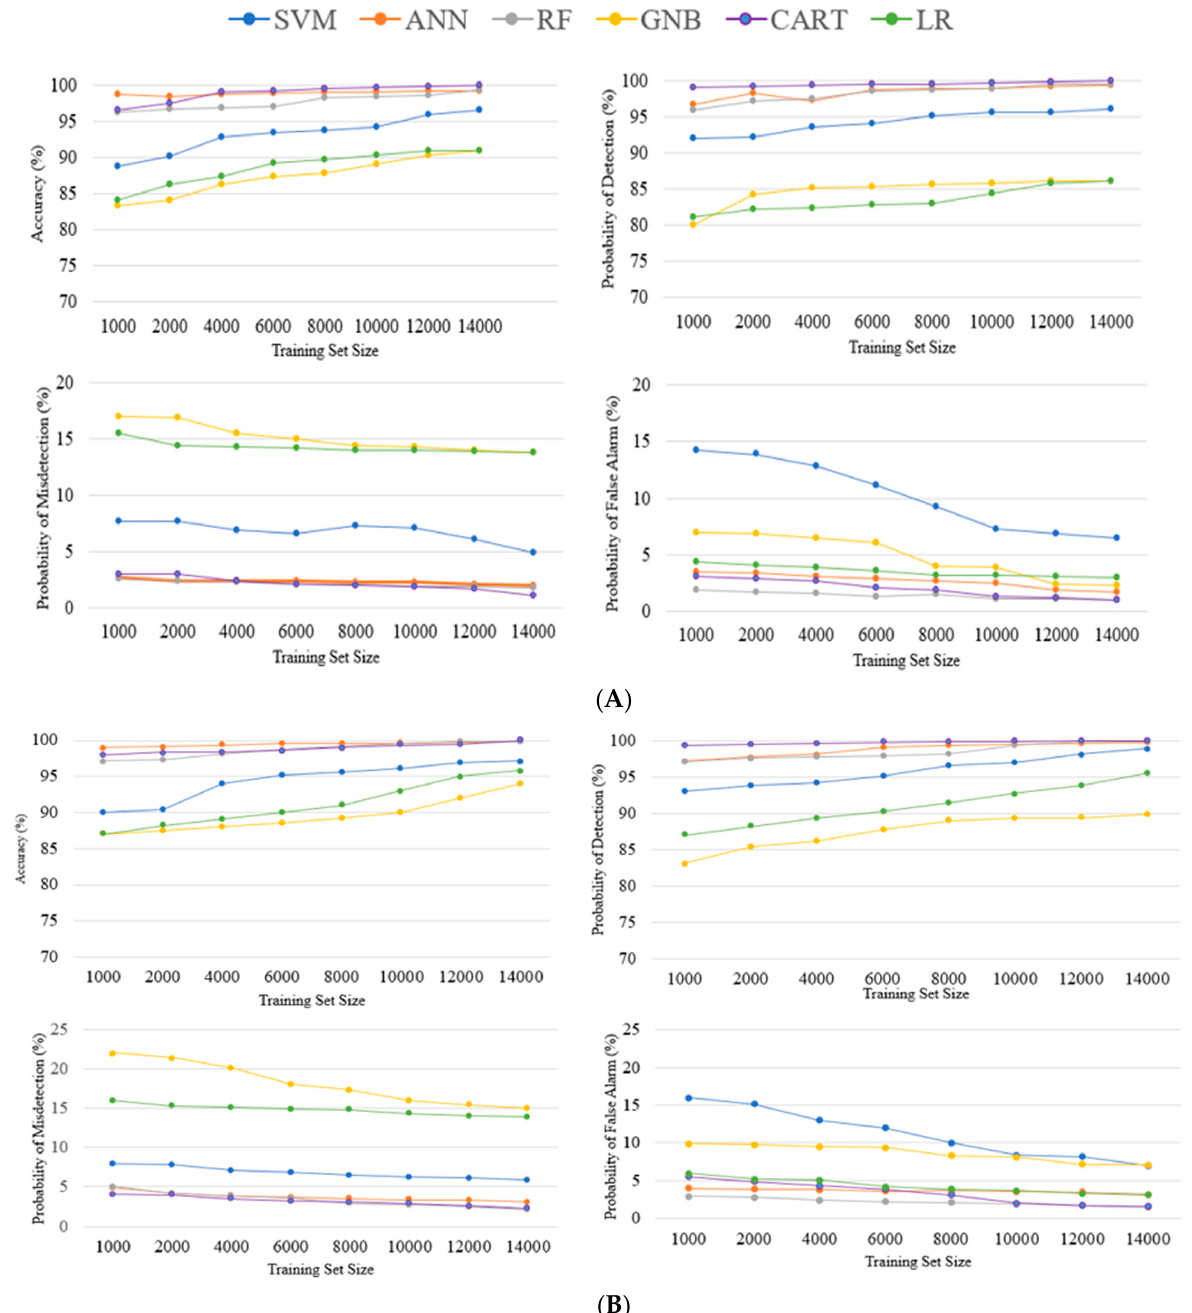
Figure 7. Impact of training set size on model performance. ( A ) Without correlation; ( B ) With cor- relation.